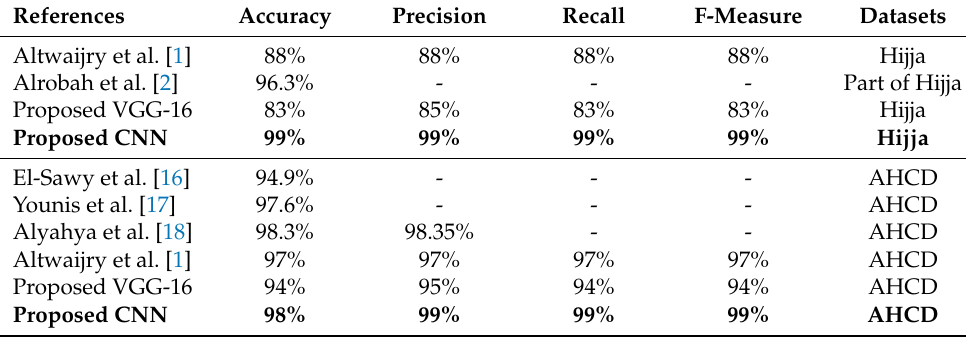
Table 4. Performance comparison with models from the